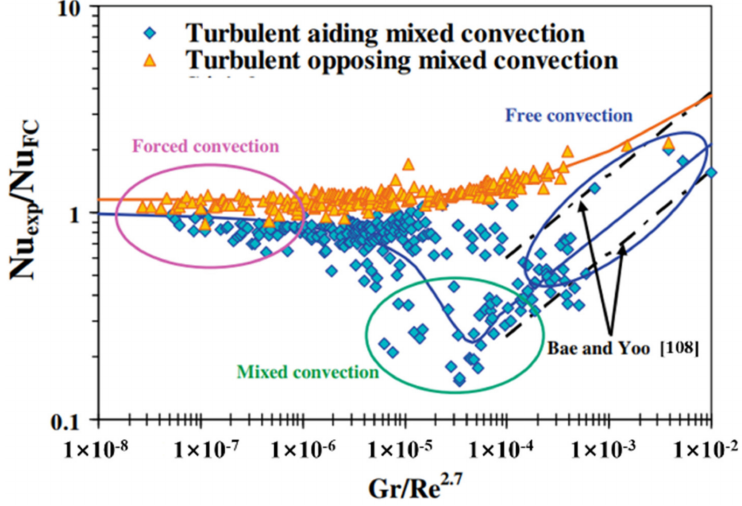
Figure 10. Evolution of Nu with the mixed convection parameter